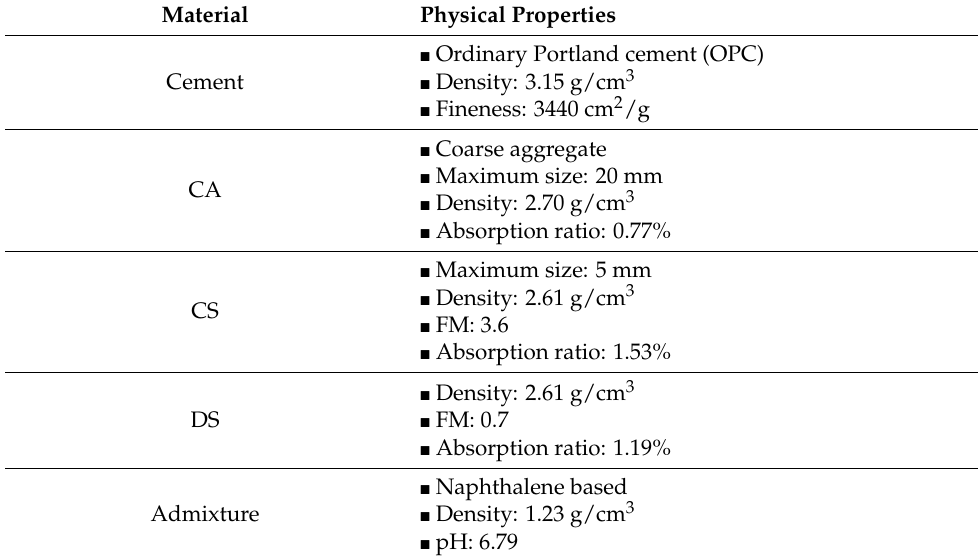
Table 1. Materials used in this study and their physical properties.